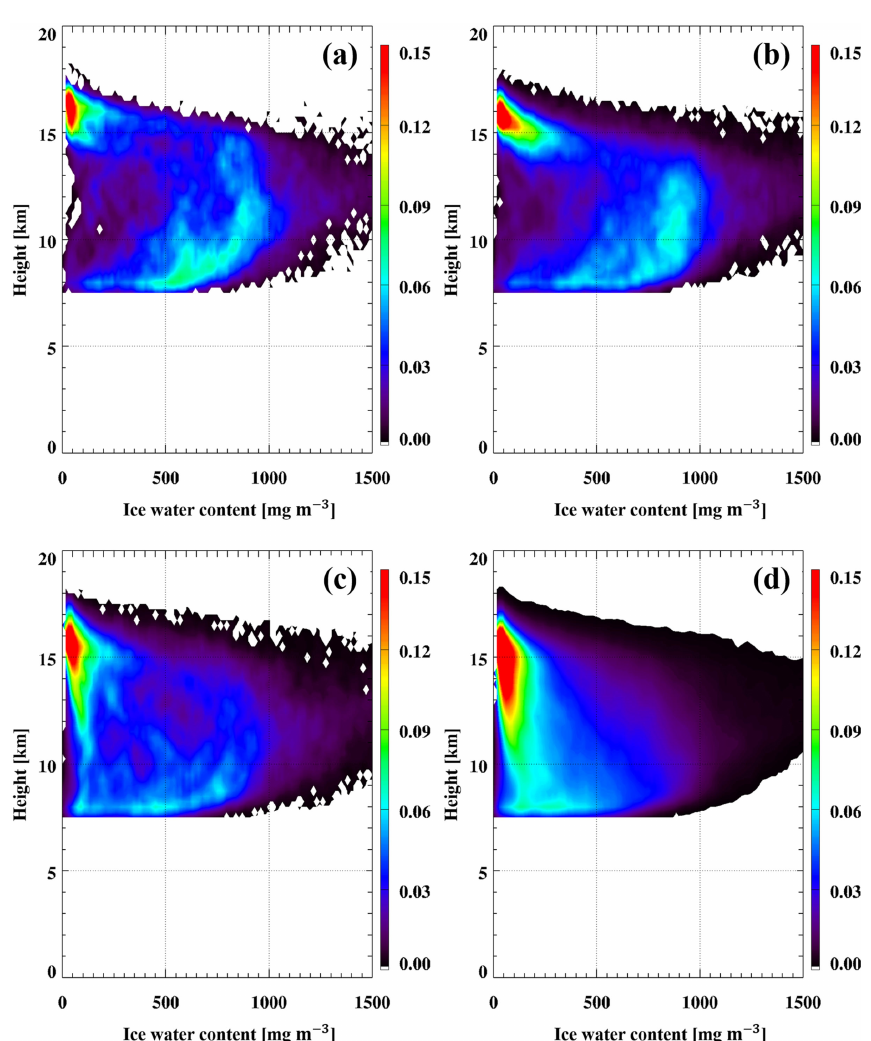
Figure 6. Same as Fig. 3 but for CloudSat-derived ice water